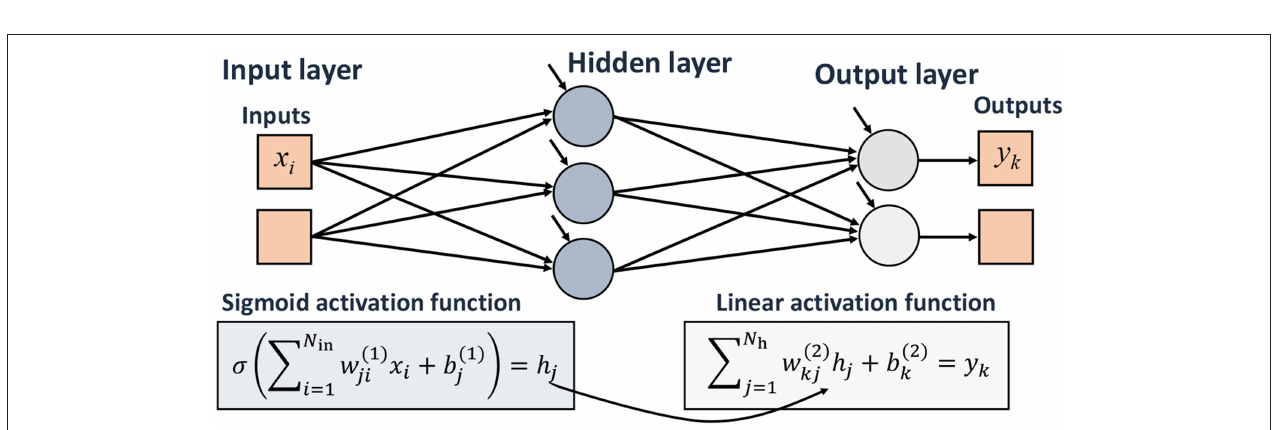
FIGURE 1 | Schematic of an artificial neuron. Here, x i and w ji are inputs and corresponding weights, b j is the neuron’s bias (interpreted as a weight associated with a unit input), h j is the neuron’s output.